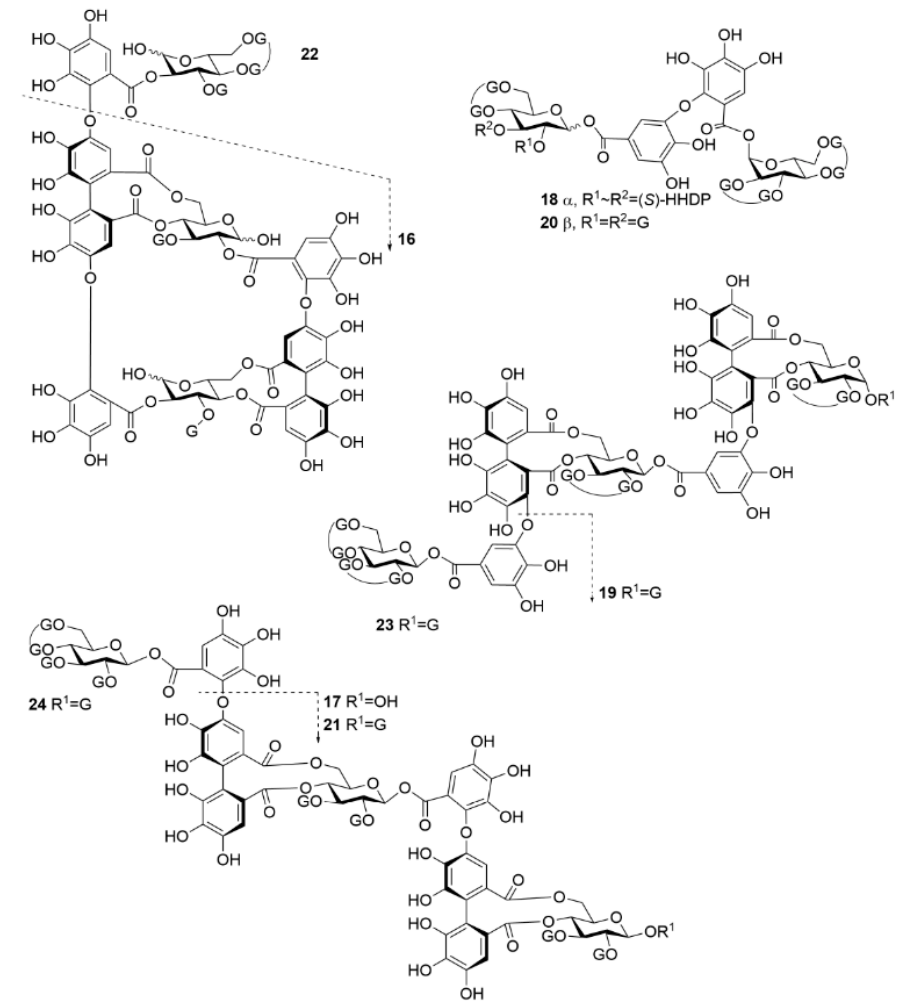
Figure 2. Chemical structures of oligomeric hydrolysable tannins used in the study. 16 , oenothein B; 17 , rugosin E; 18 , agrimoniin; 19 , sanguiin H ‐ 6; 20 , gemin A; 21 , rugosin D; 22 , oenothein A; 23 , lambertianin C; 24 , rugosin G. See Figure 1 for the structures of the substitute groups.